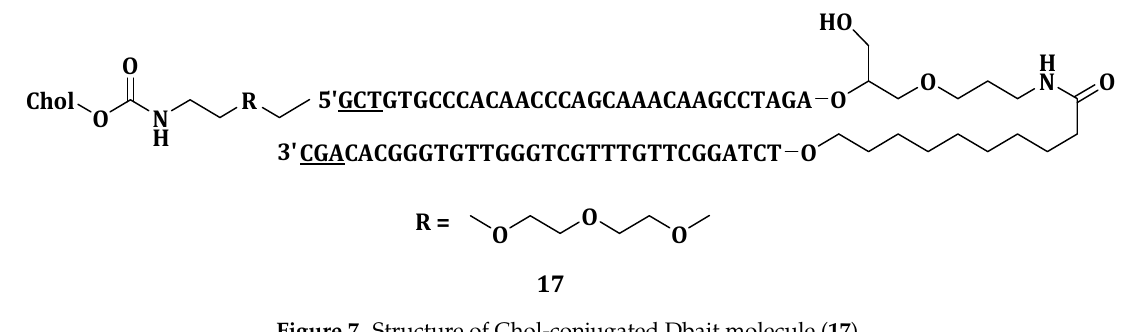
Figure 7. Structure of Chol-conjugated Dbait molecule ( 17 ).